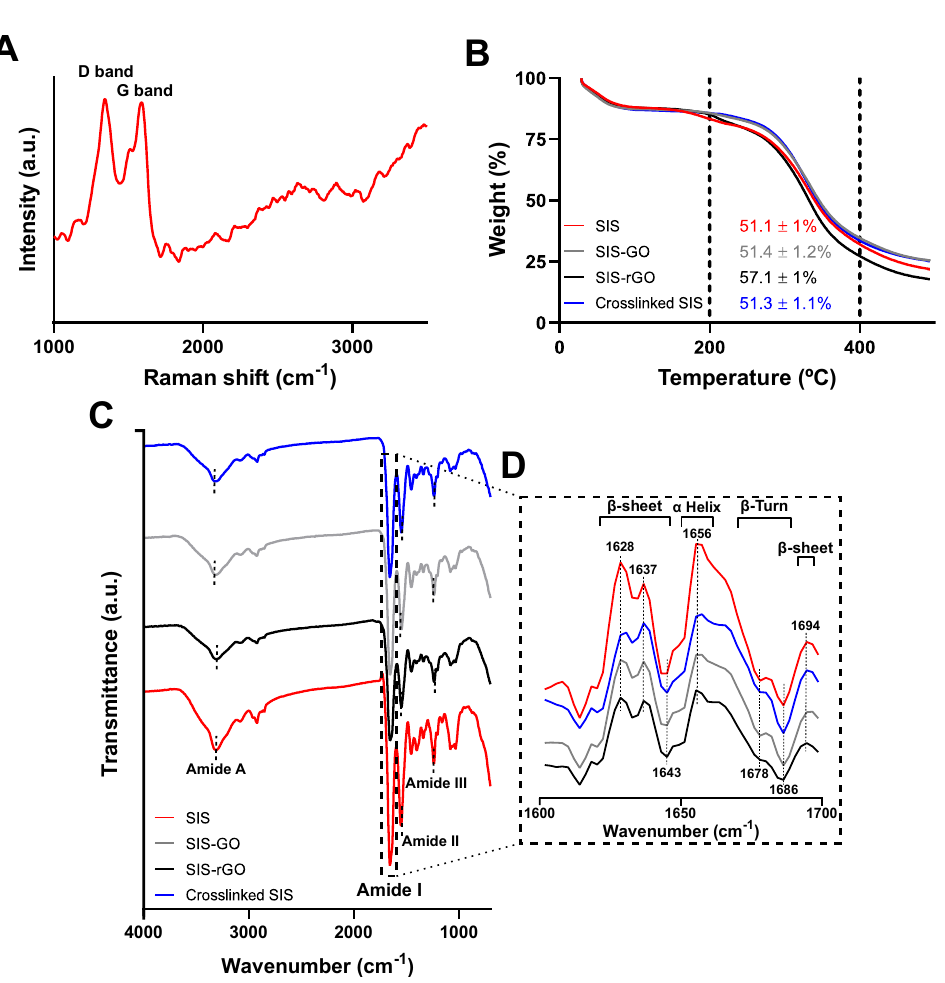
Figure 3. Characterization of the scaffolds. ( A ) Raman spectra of SIS-rGO scaffold. ( B ) TGA and ( C ) FTIR analysis of the developed nanocomposites. ( D ) Second derivative of the FTIR spectra in range of the amide I band (1700−1600 cm −1 ). Figure 3C,D show the FTIR and the second derivative analysis of SIS, crosslinked SIS, SIS-GO and SIS-rGO scaffolds, respectively. FTIR spectra for all the scaffolds present a peak at 3330 cm −1 that is attributed to N=H stretching vibration (Amide A). A peak was also observed at 1655 cm −1 , which is due to the C=O stretching vibration (Amide I), the one at 1550 cm −1 to C–O and N−H combined bending vibration (Amide II) and that at 1250 cm −1 to C–N stretching vibration. Finally, N−H bending and C–C stretching (Amide III) vibrations of collagen type I (main component of the scaffolds) were also identified [33]. It is important to note that the peak at 1640 cm −1 is not only related to the amide I band,